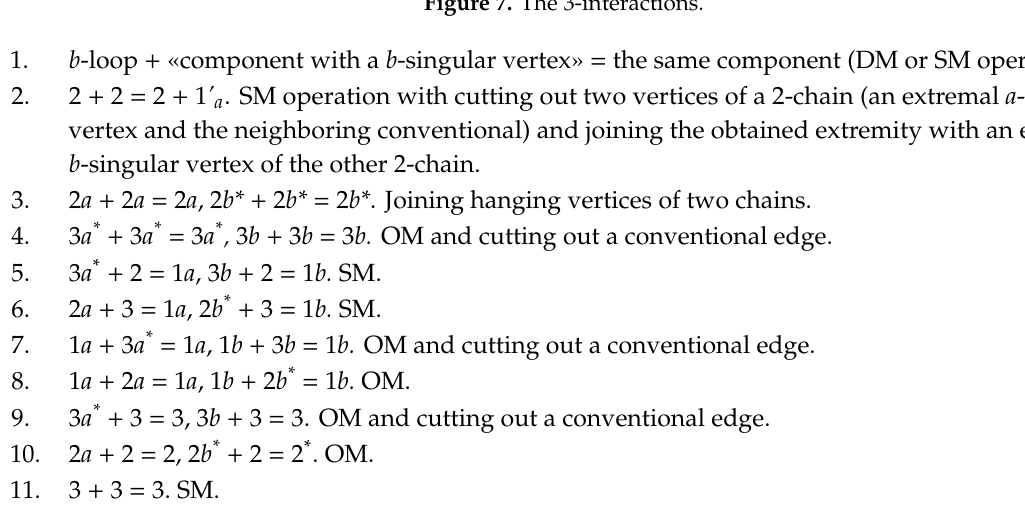
Figure 7. The 3-interactions.